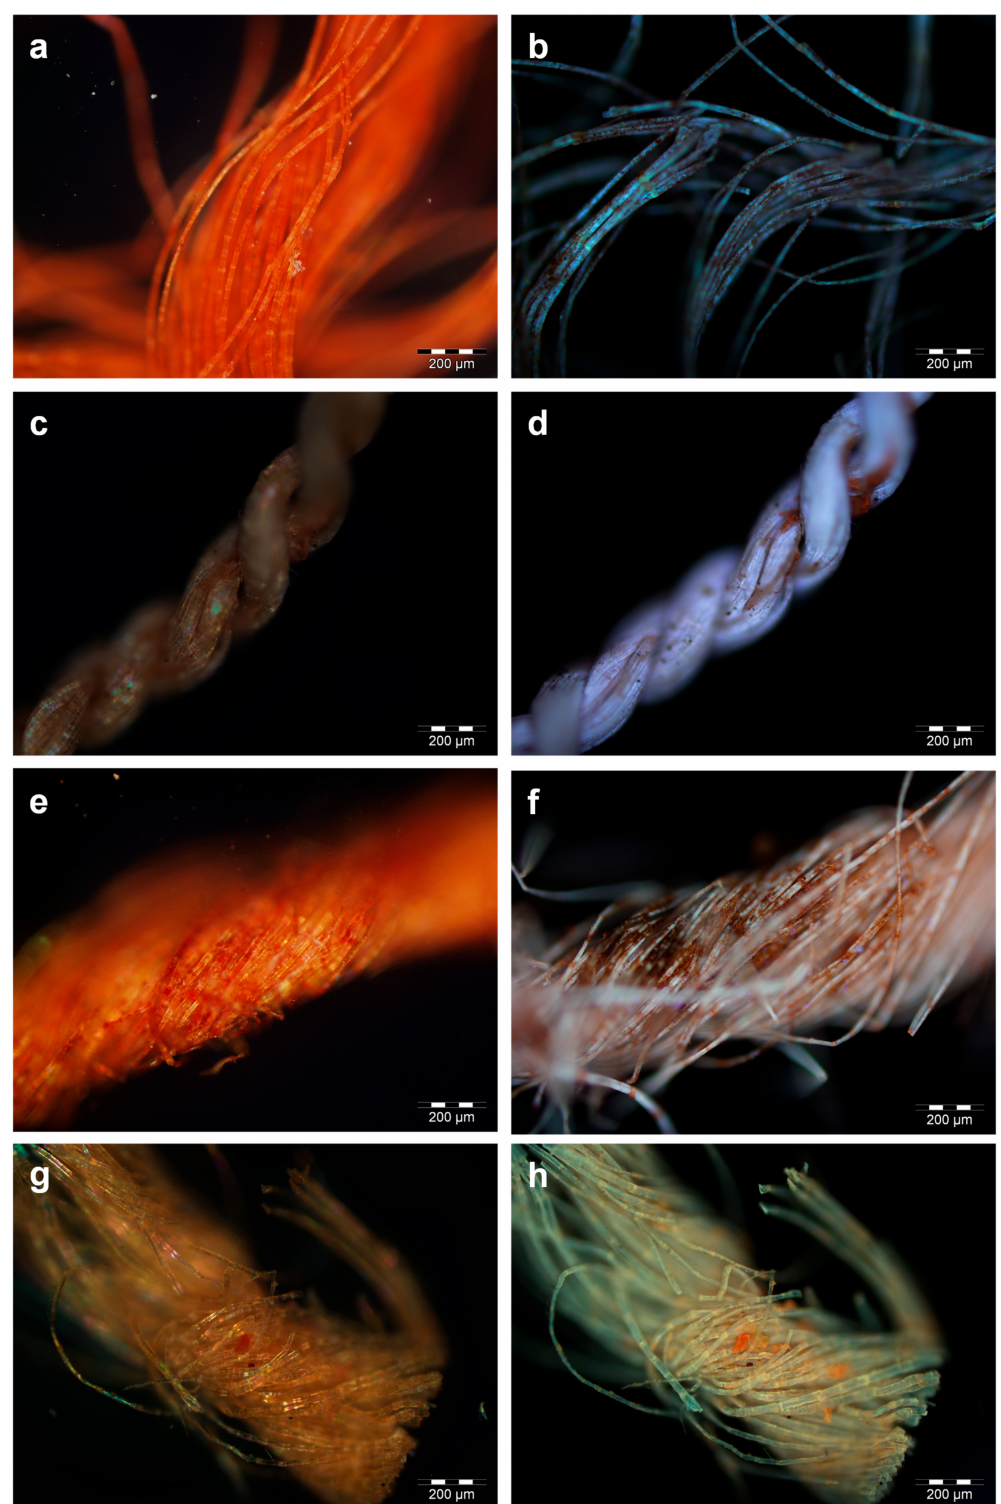
Figure 5. Optical microscopy (OM) images of sample ME7 (red ochre) as observed under visible ( a ) and UV ( b ) illumination; OM images of sample BM5 (madder and tannins) as observed under visible ( c ) and UV ( d ) illumination; OM images of sample ME2 (madder and tannins) as observed under visible ( e ) and UV ( f ) illumination; OM images of sample BM6 (sa ffl ower) as observed under visible ( g ) and UV ( h )